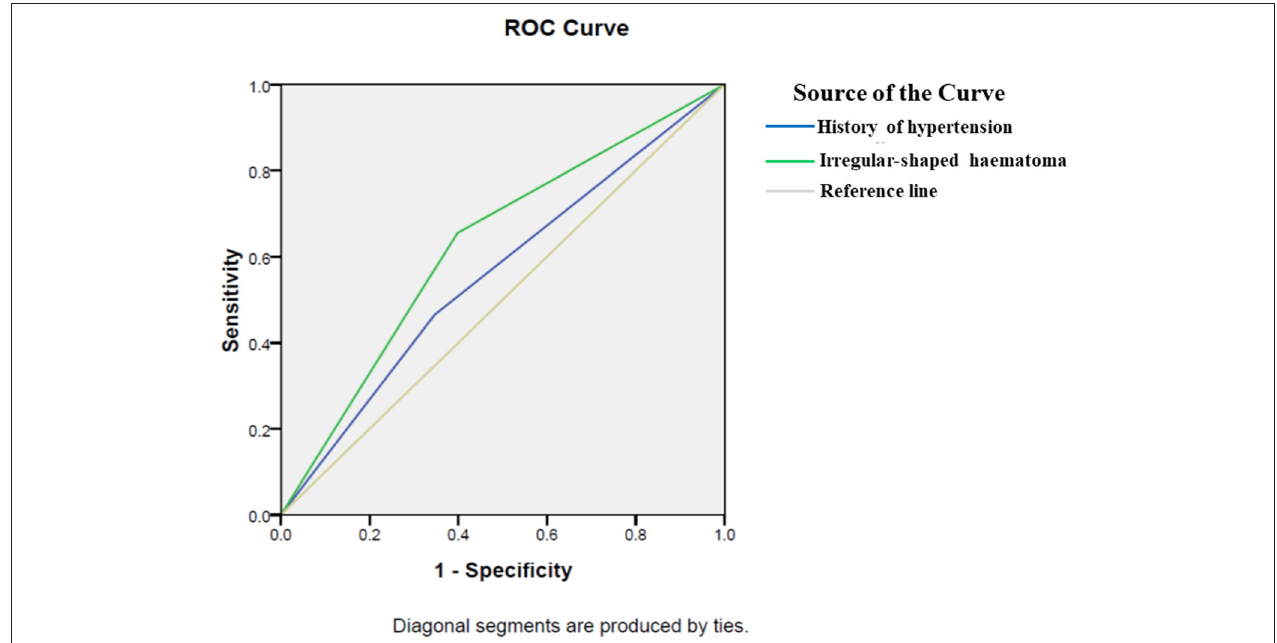
FIGURE 4 | A receiver operating characteristic for predictors of postoperative rehemorrhage. A receiver operating characteristic (ROC) curve was used to confirm the value of irregular-shaped hematoma and history of hypertension in predicting postoperative rehemorrhage following sMIS. The area under the curve of history of hypertension was 0.559( p = 0.05). Therefore, a history of hypertension cannot predict postoperative rehemorrhage. However, ROC curve analysis confirmed the value of ISH in predicting postoperative rehemorrhage in patients after sMIS, with an area under the curve of 0.629 ( p < 0.05).